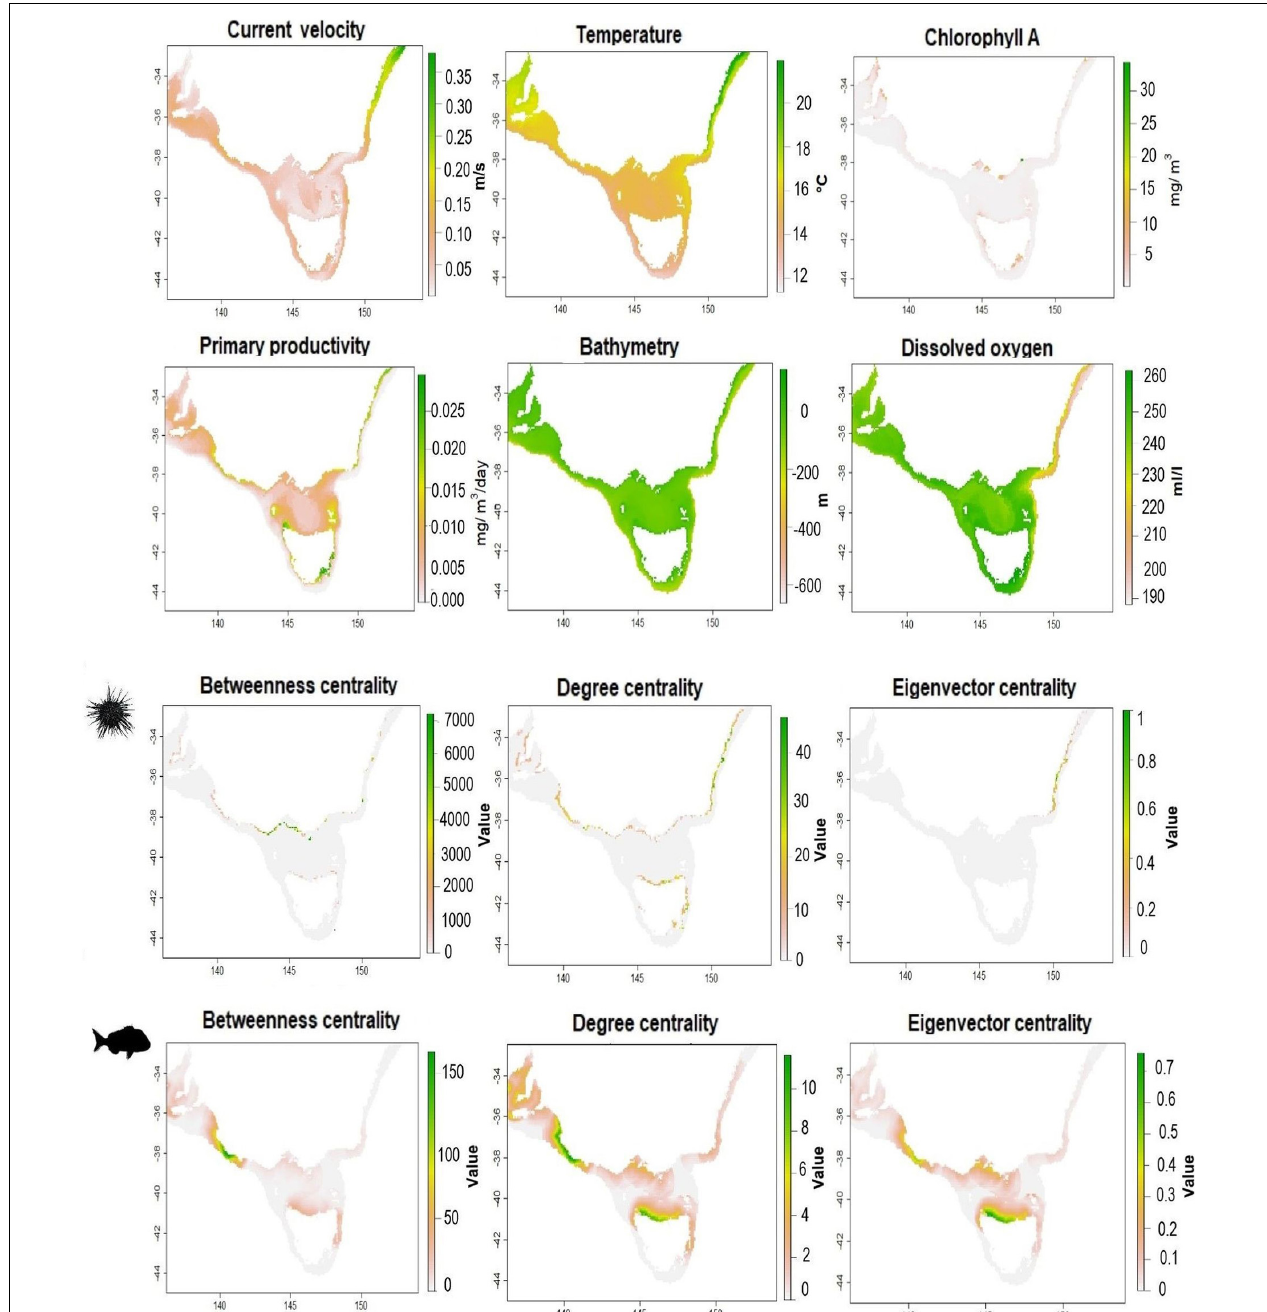
FIGURE 2 | Maps of environmental and connectivity predictors used in the SDMs for purple sea urchin, H. erythrogramma (top) , and snapper, C. auratus (bottom) . All Maps in WGS84.